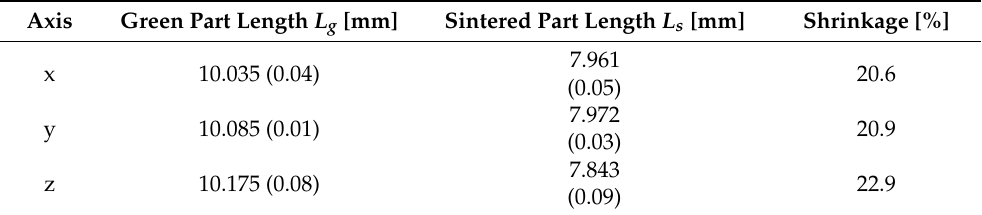
Table 3. Dimensions of green and sintered parts, with actual shrinkages. Mean values are reported, with standard deviations in brackets.